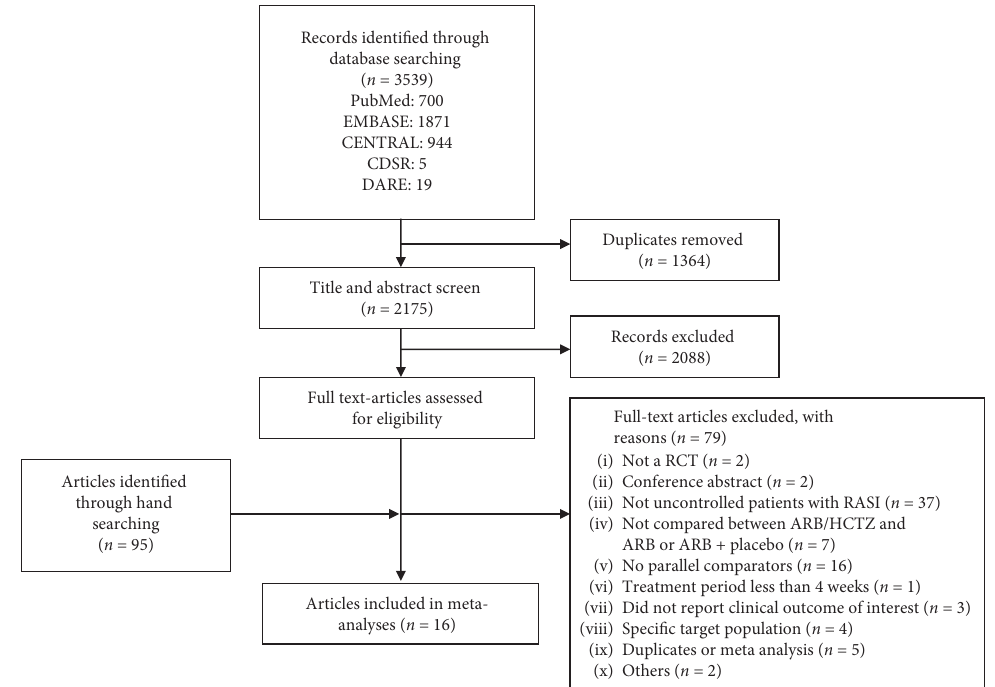
Figure 1: Flow chart of article selection through the review process. Abbreviations: randomised controlled trial (RCT), angiotensin II receptor blocker (ARB), hydrochlorothiazide (HCTZ), the Cochrane Central Register of Controlled Trials (CENTRAL), the Cochrane Database of Systematic Reviews (CDSR), Database of Abstracts of Reviews of Effects (DARE).